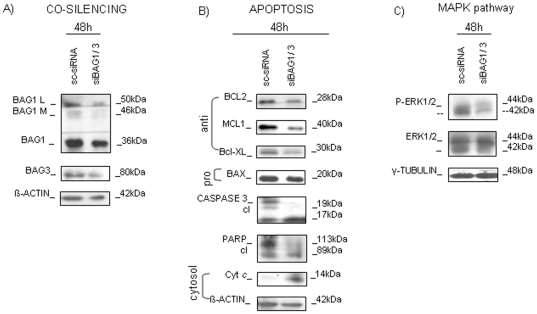
BAG1/3 co-silencing (BCS) in primary AML cultures.A) WB of co-silencing is shown for BAG1 and BAG3 expression after 48 h of transfection B) The expression of pro- and anti-apoptotic proteins was validated by WB 48 h post-transfection. Apoptotic hallmarks, CASPASE-3 and PARP, and their cleavage (cl) was examined. The release of Cyt c was evaluated in cytosol protein fraction. C) WB analysis for ERK1/2 expression after transfection with siBAG1/3 or sc-siRNA β-ACTIN, and γ-TUBULIN are shown as total protein loading controls.